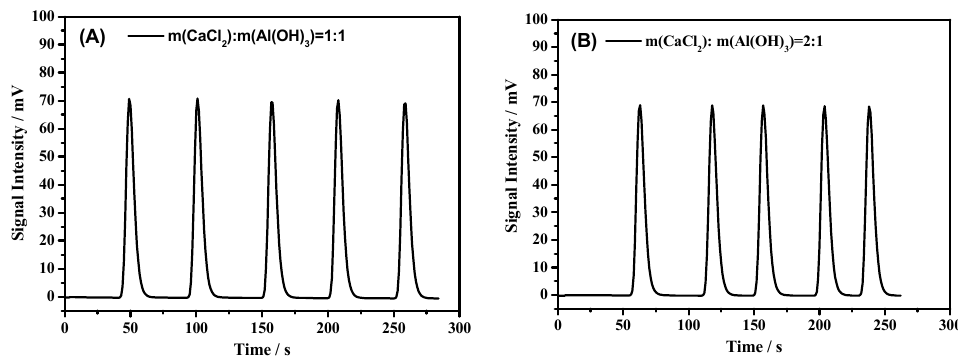
Figure 9. Adsorption performance of a mixture of desiccant and HF adsorbent on CO 2 , with a mass ratio of CaCl 2 to Al(OH) 3 equal to ( A ) 1:1, ( B ) 2:1. Table 3. Adsorption performance of the materials on CO 2 based on the integrated area of pulse peaks. Items